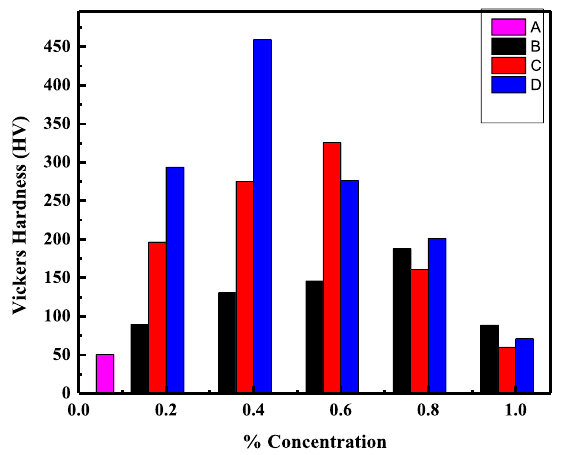
Fig. 13 Vicker ’ s hardness of AR ( A ), C m C ( B ), WC ( C ), and CC ( D ) against % concentration of fi llers in these composites at 8